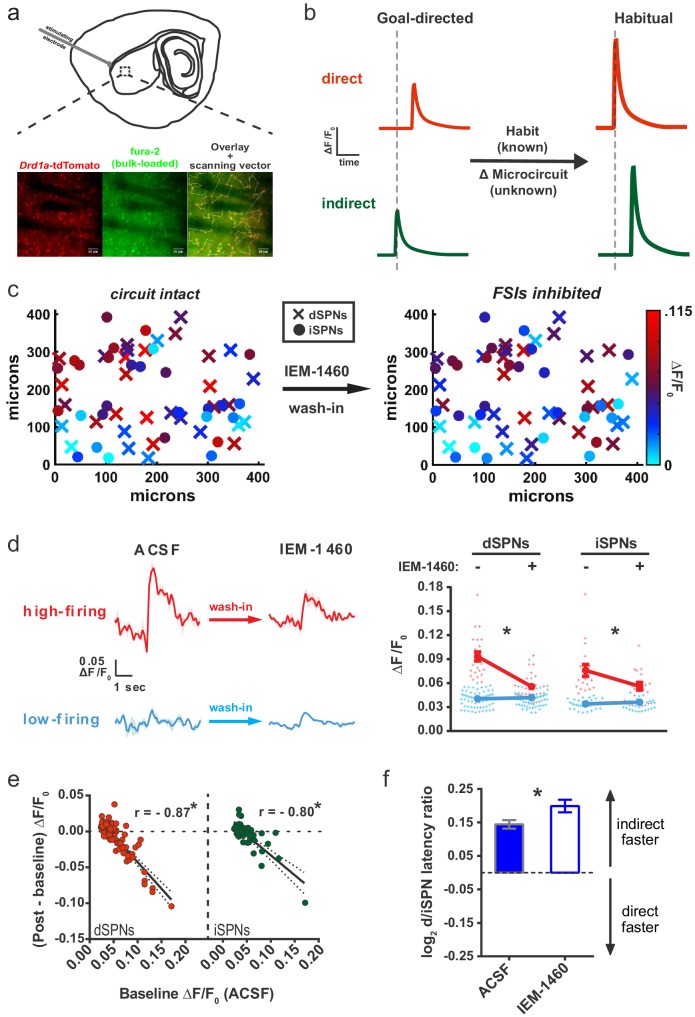
Striatal output reconfiguration following pharmacological inhibition of FSIs directly opposes substrates for habitual behavior.(A) Schematic of calcium imaging approach. Top: SPN activity was evoked by electrical stimulation of cortical afferent fibers in an acute parasaggital brain slice. Bottom: Evoked SPN firing was imaged in the direct and indirect pathways simultaneously using a transgenic direct pathway reporter mouse line (left), calcium indicator dye fura-2 (middle) and two-photon laser scanning microscopy (right, see scanning vector in overlay). (B) Experimental approach. Striatal microcircuitry was manipulated in tissue from untrained animals in order to reproduce the known circuit substrate for habitual behavior (described in O'Hare et al., 2016) and thereby identify a candidate microcircuit mechanism. (C) Representative heat maps of dSPN (x) and iSPN (●) calcium transient amplitudes before (left) and after (right) pharmacological inhibition of FSIs using IEM-1460 show a selective reduction in cells with the strongest (bright red) initial responses. (D) Left: Representative SPN calcium transient waveforms before and after wash-in of IEM-1460. SPNs were grouped into ‘high-firing’ (red) or ‘low-firing’ (blue) clusters based solely on their baseline response amplitudes using a Gaussian mixture model. SPNs with strong baseline responses (red, ‘high firing’) show weaker responses after wash-in whereas those with initially weak responses (blue, ‘low firing’) are unaffected. Right: Evoked calcium transient amplitudes for all imaged SPNs before (-) and after (+) wash-in of IEM-1460. For both cell types, high-firing SPNs showed decreased responses after IEM-1460 wash-in (dSPNs: t(22) = 6.43, p=0.0000018, n = 23 cells; iSPNs: t(17) = 3.43, p=0.0032, n = 18 cells) whereas low-firing SPNs did not (dSPNs: p=0.24, n = 64 cells; iSPNs: p=0.21, n = 34 cells). (E) Linear regression and correlational analyses show that the inhibitory effect of IEM-1460 on SPN responses (post – baseline difference) is a linear function of baseline response amplitudes for both dSPNs (red; r(86) = −0.87, p=2.20×10−28, n = 87 cells) and iSPNs (green; r(51) = −0.80, p=1.59×10−12, n = 52 cells). (F) Relative pathway timing, as measured by latency to peak detection, before and after inhibition of FSIs using IEM-1460. Indirect pathway activation precedes direct pathway activation by a greater margin after wash-in of IEM-1460 (t(102) = 2.42, p=0.017, n = 52 independent dSPN/iSPN pairs). *p<0.05. Dotted error bands indicate 95% confidence interval. Error bars indicate SEM. Effects of IEM-1460 on FSI and SPN spike probability are shown in Figure 1—figure supplement 1. Electrophysiological assessment of IEM-1460’s effect on evoked multi-AP SPN responses is included in Figure 1—figure supplement 2. GMM parameters and calcium transient amplitude source data can be found in Figure 1—source data 1.10.7554/eLife.26231.006Figure 1—source data 1.GMM parameters and source data for SPN calcium transient amplitudes (MATLAB).GMMs contains parameters for the Gaussian mixture model fits on pre-IEM-1460 calcium transient amplitude data by cell type. Amplitude values are included for high- and low-firing dSPNs and iSPNs in dSPNs_high, dSPNs_low, iSPNs_high, and iSPNs_low. Matrices are N x 2 with column 1 containing pre-drug amplitudes and column 2 containing paired measurements after drug wash-in. Data can be combined within cell type and analyzed using source code file PrePostGMM.m to reproduce the clustering shown in Figure 1D (see comments in code).